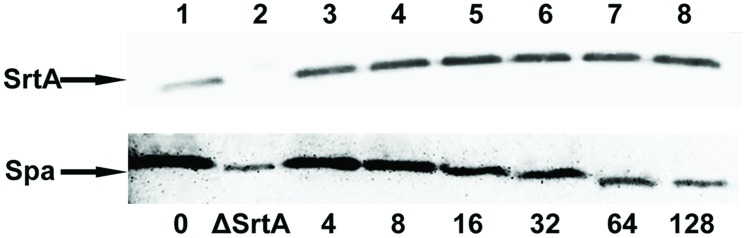
Western blot analysis of sortase A (SrtA) protein and protein A (Spa). Proteins released from the cytoplasmic membrane (SrtA) or cell wall (Spa) of S. aureus Newman D2C (lanes 1, 3–8) and ΔSrtA (lane 2) grown in the absence or in the presence of CHA were fractionated by SDS-PAGE, transferred to polyvinylidene fluoride membranes. SrtA was detected with specific anti-SrtA rabbit antibodies and Spa was detected with specific anti-protein A chicken antibodies.